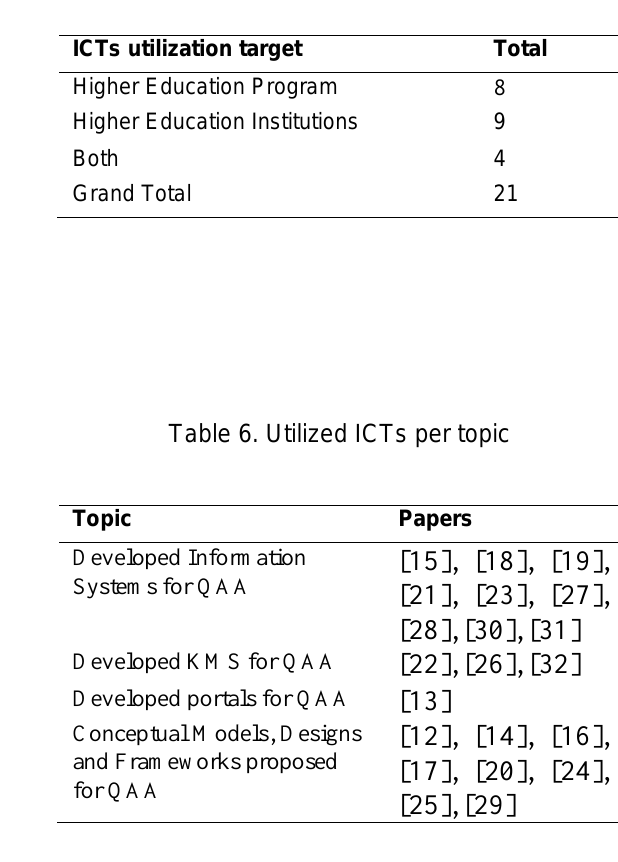
Table 5. Frequency of published papers categorized by the ICT utilization target (RQ3)